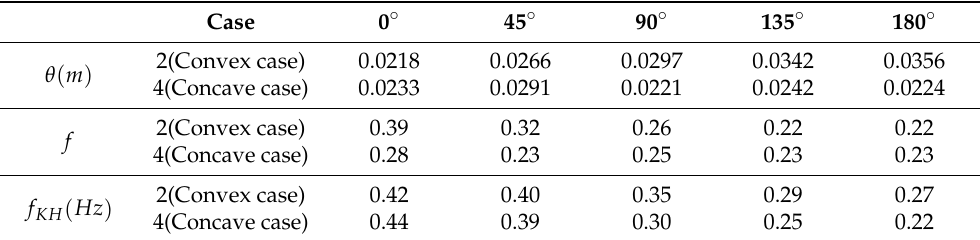
Table 2. The momentum thickness and K-H instability frequency for Cases 2 and 4.